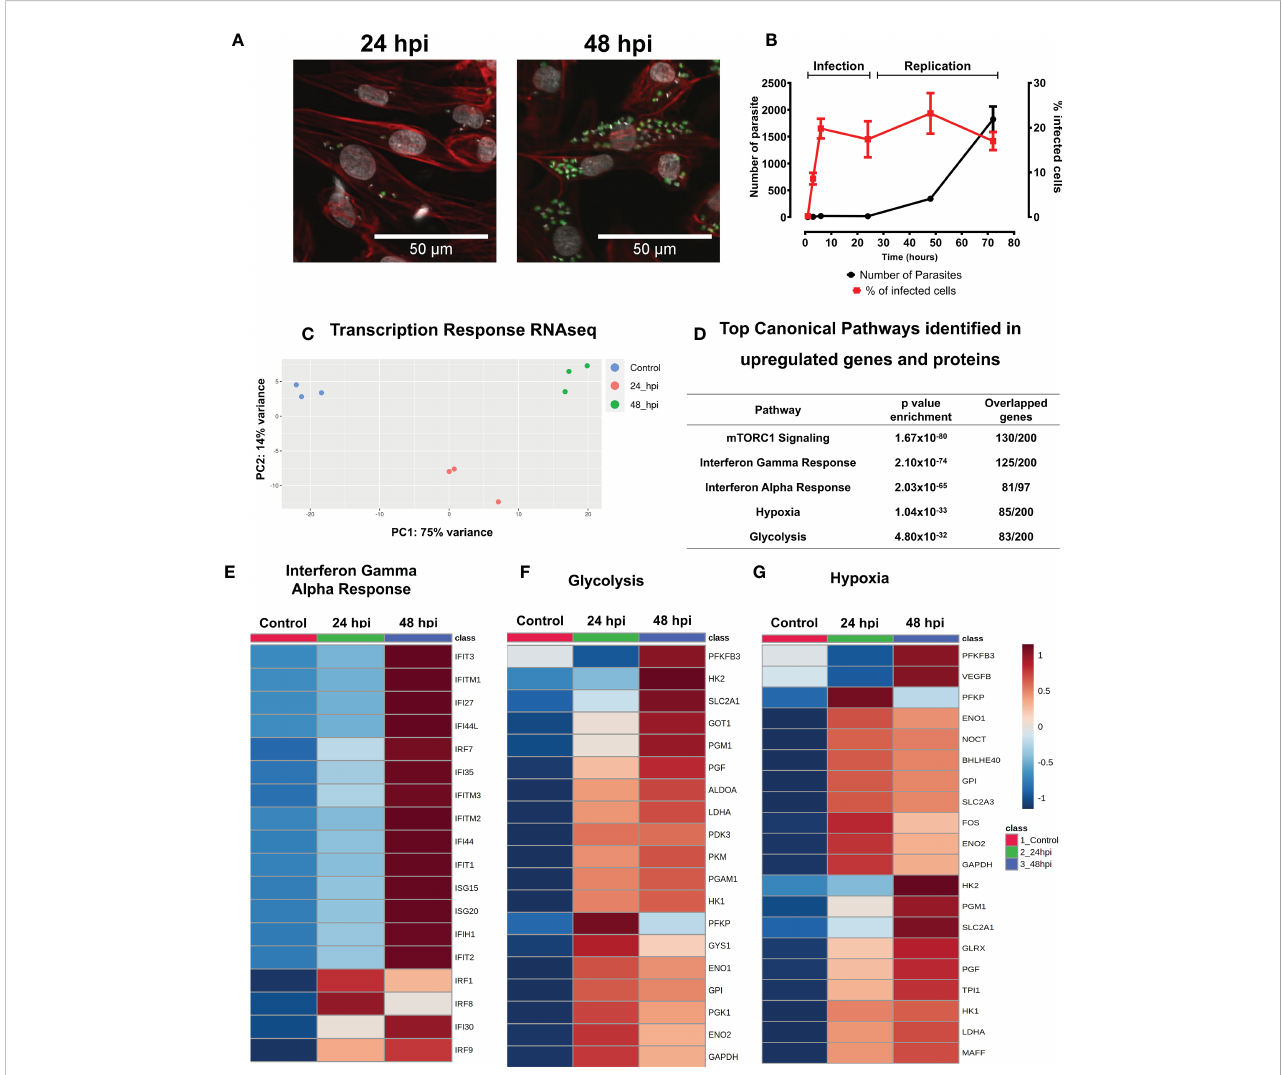
FIGURE 1 T. cruzi infected IPSC-CMs activate immune responses. (A) With a multiplicity of infection (MOI) 5:1 (parasite:cell), 20% of iPSC-CMs contain parasites at 24 hours that multiply 4-fold by 48 hpi, and lyse cells by 72 hpi. Fluorescent images are at 24 hpi and 48 hpi detect GFP-tagged T. cruzi (green), phalloidin-strained actin (red) and DAPI-stained nuclei (grey). (B) Percentage of infected iPSC-CMs and parasite numbers during infection and replication phases. (C) Transcriptomic pro fi les of iPSC-CMs displayed by principal component analyses. Control, uninfected (blue), 24 hpi (red) and 48 hpi (green) showing overall difference among groups in a PCA plot. (D) Top Canonical Pathways enriched by both, genes and proteins, upregulated after 24 hpi and 48 hpi. (E – G) . Heatmaps of differentially expressed genes involved in glucose metabolism, HIF-1 a signaling, and interferon